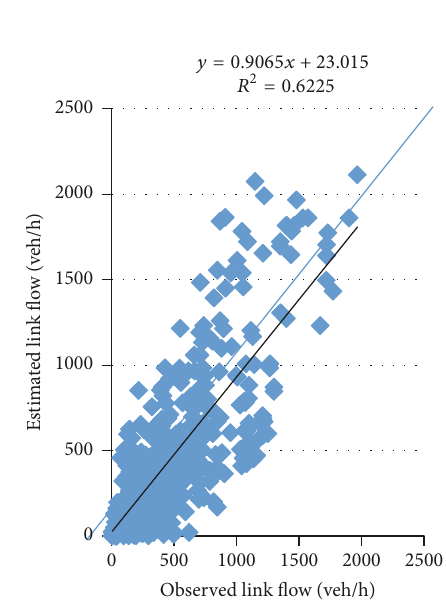
Figure 8: Result of TCoE at 22:00.